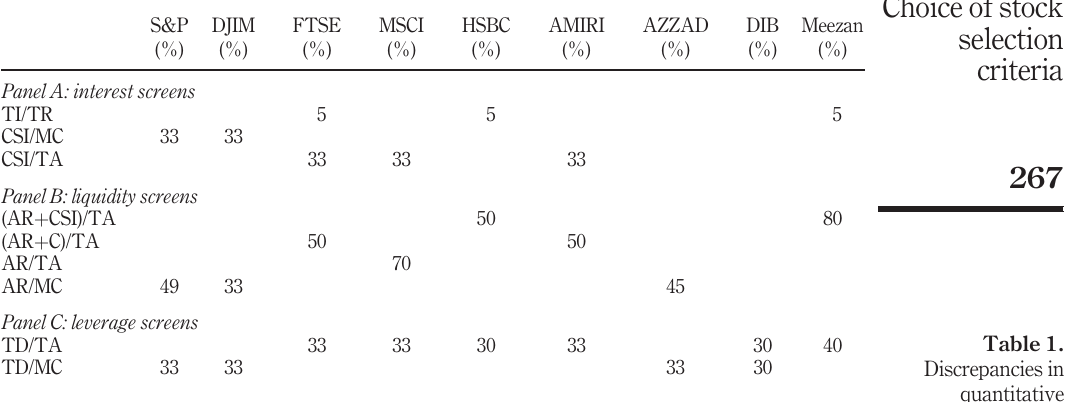
Table 1. Discrepancies